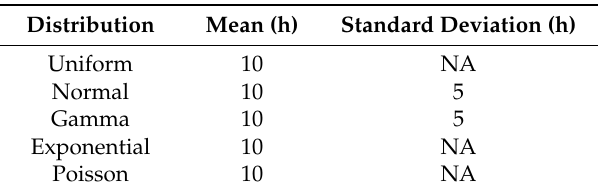
Figure 6. Outage repair time distributions for small, large and extreme storms. Crews start at area work centers and find the nearest outage. Travel speed set to 25 mph, 272 crews with 85% working during day shift, 99% working during evening shift and 66% working during night shift and nearest outage search strategy. ETR curve was insensitive outage repair time distribution. Table 4. Distribution characteristics from Figure